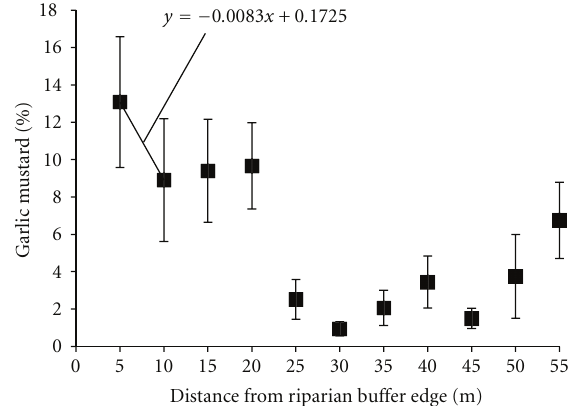
Figure 3: The prevalence of garlic mustard away from the edge of forested riparian bu ff ers in Delaware and Pennsylvania, 2007-2008. Within-subject contrasts indicated a significant ( P < 0 . 10) linear trend through